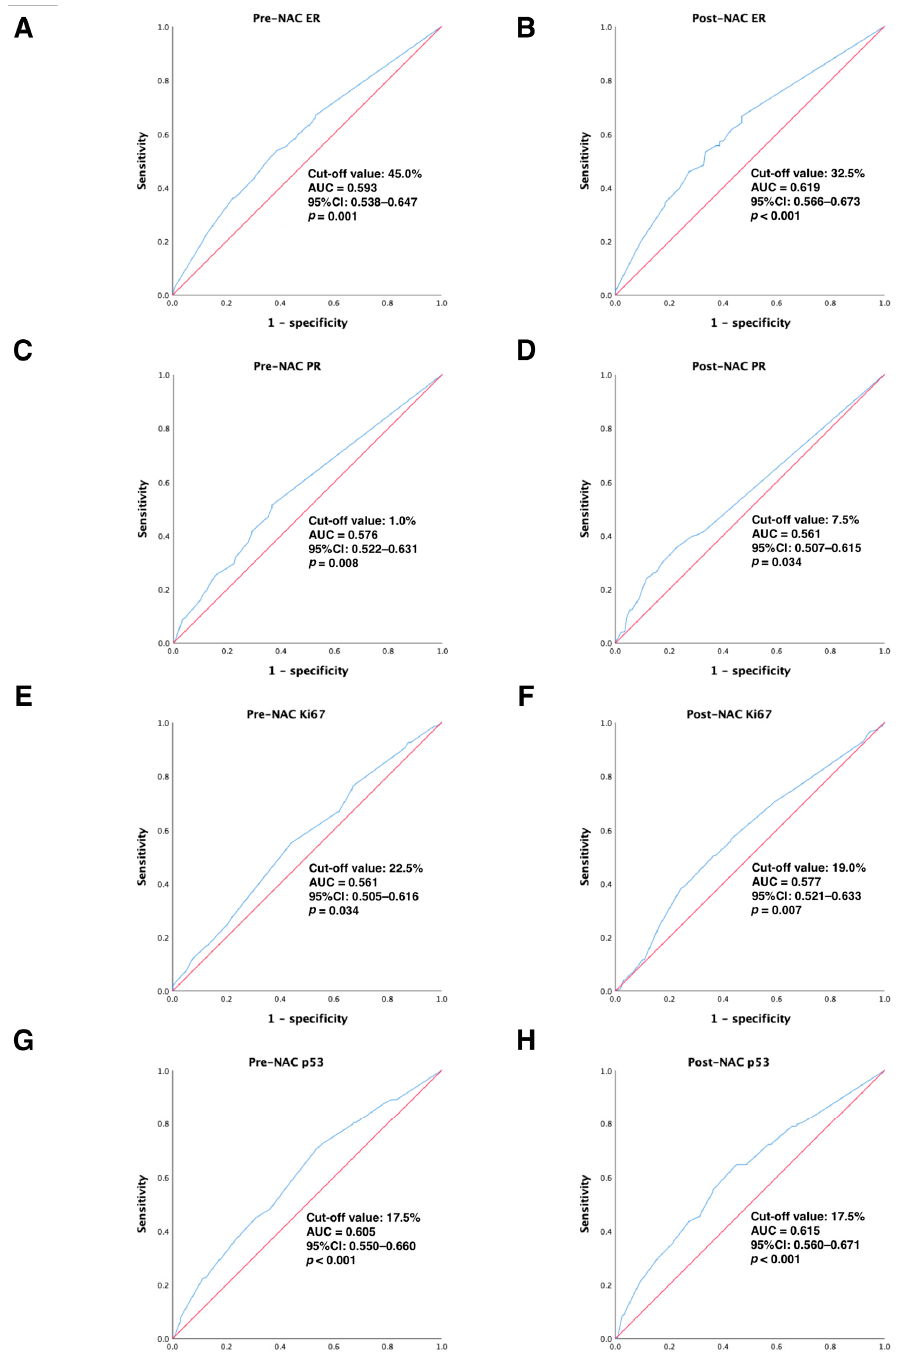
Figure 2. ROC analysis showing the best discriminative value to predict DFS outcomes for ( A ) pre-NAC ER; ( B ) post-NAC ER; ( C ) pre-NAC PR; ( D ) post-NAC PR; ( E ) pre-NAC Ki67; ( F ) post-NAC Ki67; ( G ) pre-NAC p53; ( H ) post-NAC p53 in the primary cohort. Blue line: ROC curve; Red line, reference line. Abbreviations: ROC, receiver operating characteristic; DFS, disease-free survival; AUC, area under the curve; CI, confidence intervals; ER, estrogen receptor; PR, progesterone receptor; pCR, pathologic complete